Question: Generate an informative caption for the figure above.
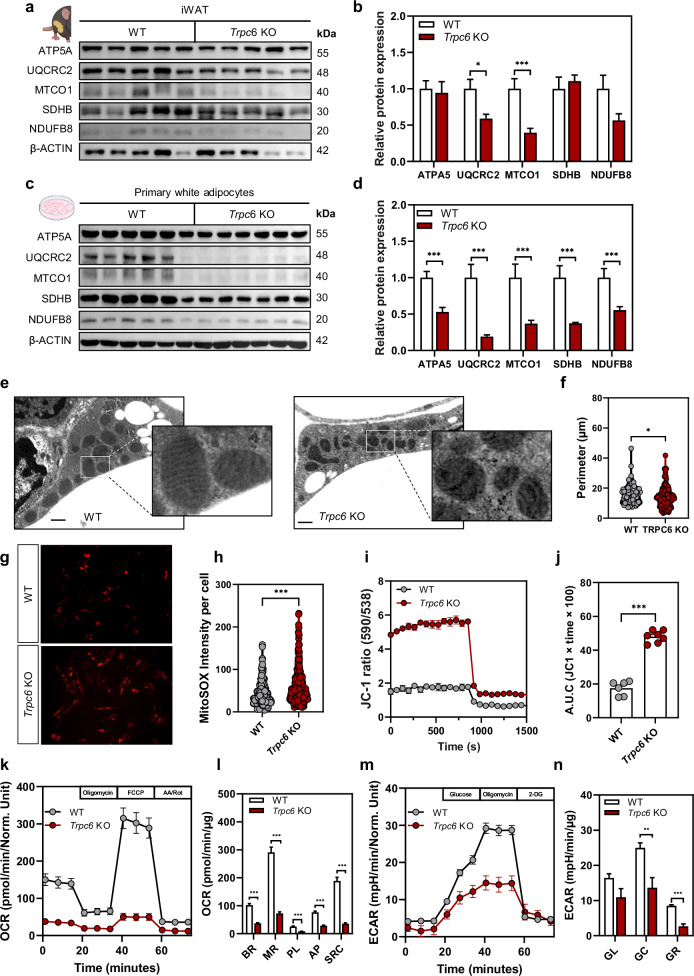
Answer: Mitochondrial dysfunction and oxidative stress accumulation in TRPC6-deficient adipocytes. Immunoblots and quantification of mitochondrial electron transport chain complex proteins in inguinal white adipose tissue (iWAT) ( n = 5 per group) (parts a and b ) and differentiated primary white adipocytes ( n = 6 per group) (parts c and d ). e Representative electron microscopic images of the iWAT (scale bar: 5 μm). f Quantification of mitochondrial perimeter, calculated from five mice per group (wild-type (WT): 9 images and Trpc6 knockout (KO): 10 images). g , h MitoSOX-based measurement of mitochondrial reactive oxygen species production in differentiated primary white adipocytes. i , j JC-1-based assessment of mitochondrial membrane potential (WT, n = 6; Trpc6 KO, n = 7). k Representative trace of the oxygen consumption rate (OCR) of WT and Trpc6 KO differentiated primary white adipocytes ( n = 6 per group). l Quantified basal respiration (BR), maximal respiration (MR), proton leak (PL), ATP-linked respiration (AP), and spare respiratory capacity (SRC) (WT, n = 18; Trpc6 KO, n = 17). m Representative trace of extracellular acidification rate (ECAR) of WT and Trpc6 KO differentiated primary white adipocytes (WT, n = 6; Trpc6 KO, n = 3). n Quantification of basal glycolysis (GL), glycolytic capacity (GC), and glycolytic reserve (GR) ( n = 5 per group). Data are mean ± SEM. Statistical comparisons were performed using an unpaired Student’s t test for bar graphs. * P < 0.05, ** P < 0.01, *** P < 0.001. AUC, area under the curve; norm., normalized.